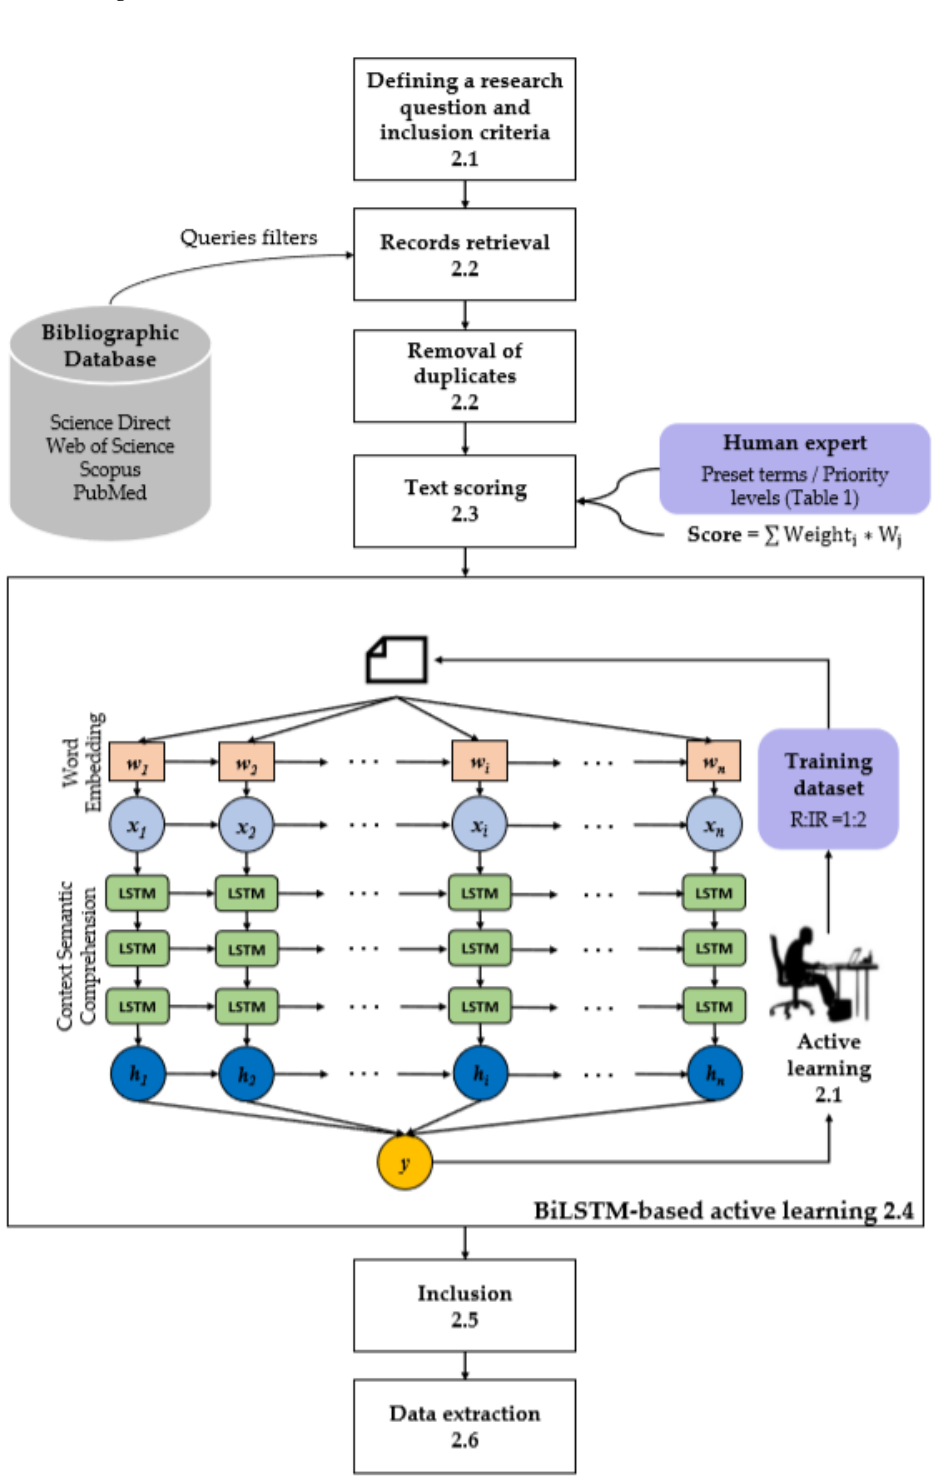
Figure 1. The overall workflow of semi-supervised text classification.